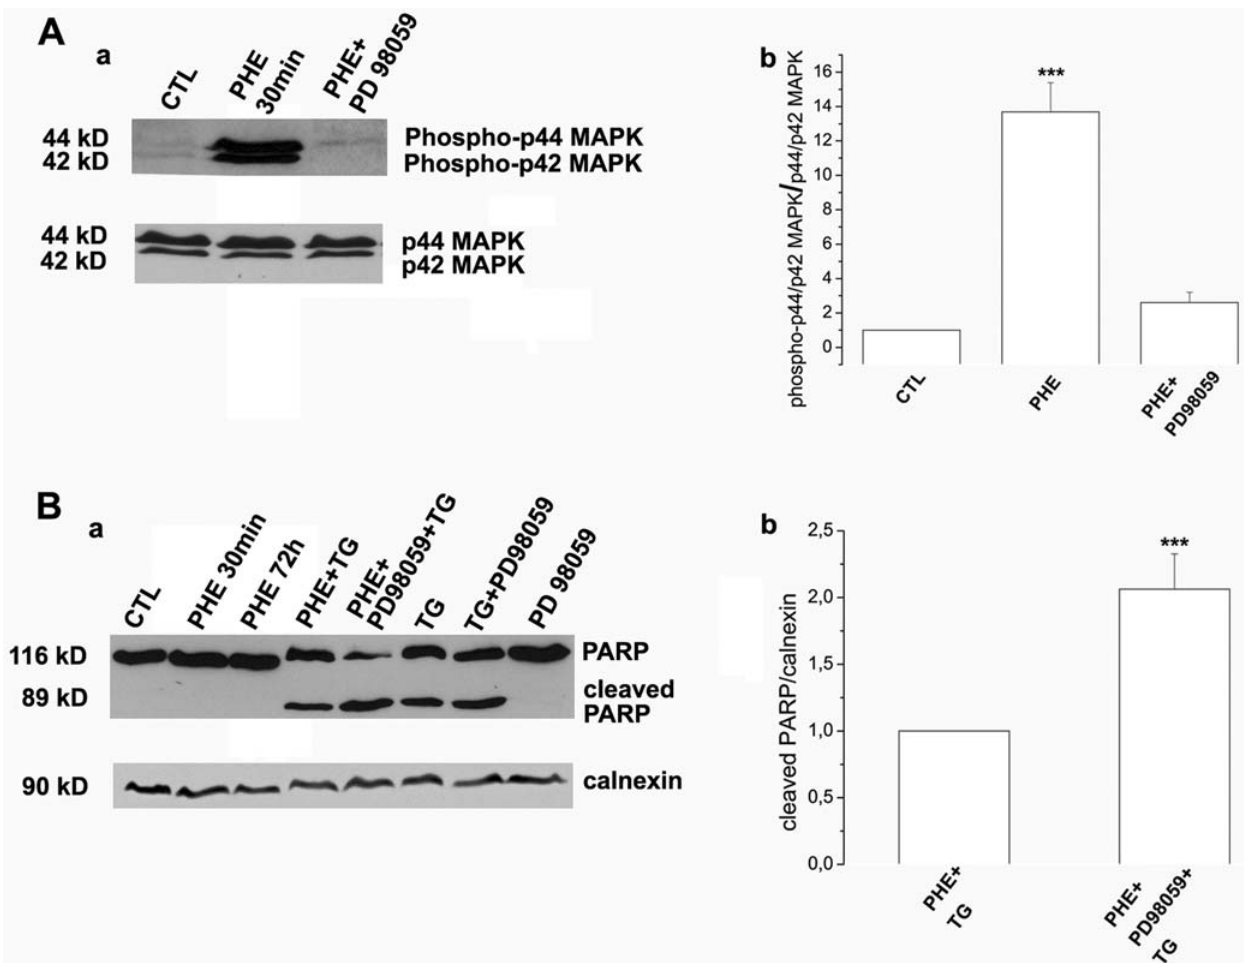
Figure 7. TG-induced apoptosis resistance in DU145 cells is mediated by ERK1/2. (A)(a) Western blot showing expression of phosphorylated p44/p42 MAPK (ERK1/2) in non-treated cells (CTL), 30 min treatment by 10 m M PHE (PHE 30 min) and simultaneous treatment by 10 m M PHE and 10 m M PD98059 (PHE + PD98059). (b) Expression of phospho-p44 and phospho-p42 MAPK is assessed on total p44/p42 MAPK in DU145 cells. (B)(a) Western blot showing expression of PARP full length fragment (116 kD) and cleaved PARP (89 kD) in the following treatment conditions: non-treated (CTL), 30 min